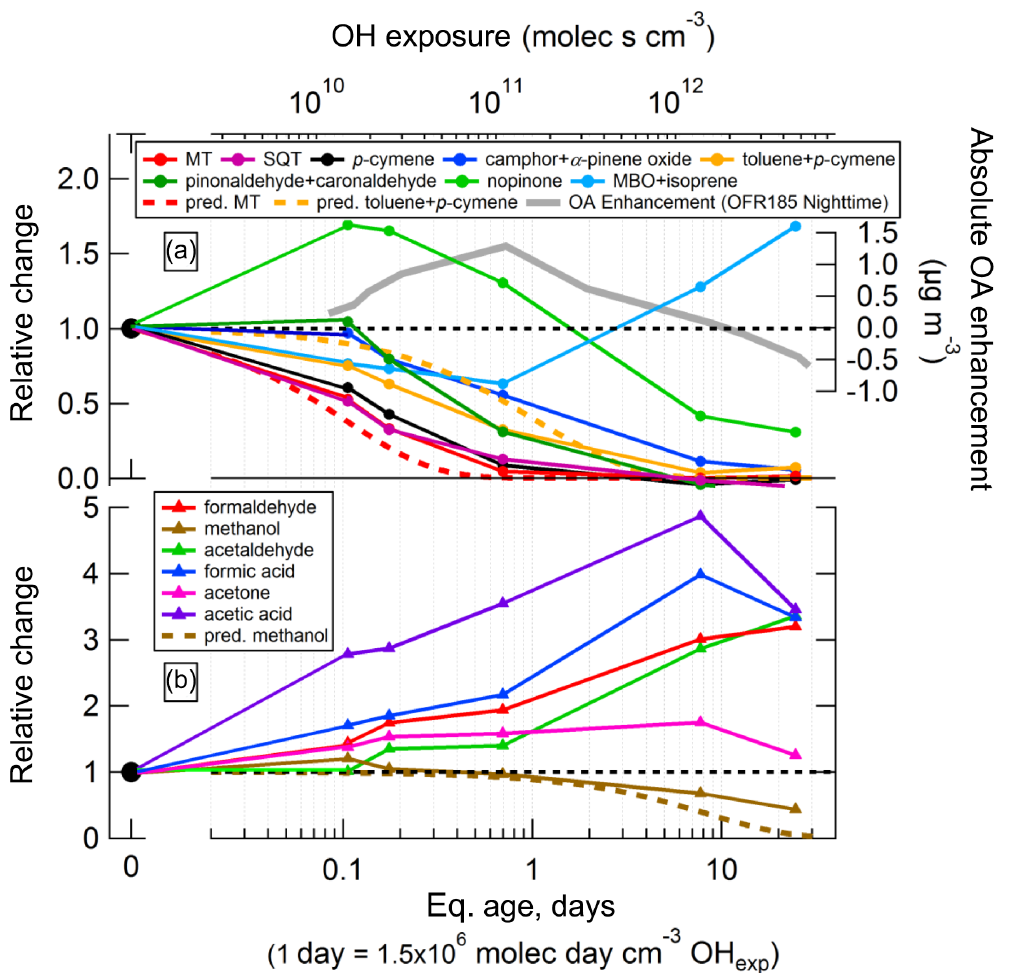
Figure 4. Relative changes in prominent PTR-TOF-MS compounds as a function of photochemical age using the OFR185 method: (a) toluene + p -cymene and terpene-related signals compared to nighttime OA enhancement using the OFR185 method (not LVOC fate corrected), and (b) oxidation products formed in the OFR. For comparison, dashed lines indicate theoretical depletion of an equal mix of α -pinene, β -pinene, and 3-carene (the three major MT at this site; Kim et al., 2010; Ortega et al., 2014); a 74:26 mix of toluene + p -cymene (Kaser et al., 2013a); and